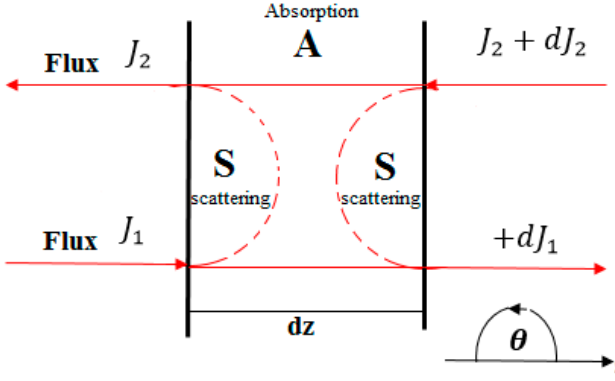
Figure 2. The Geometry of two fluxes in Kubelka-Munk theory.